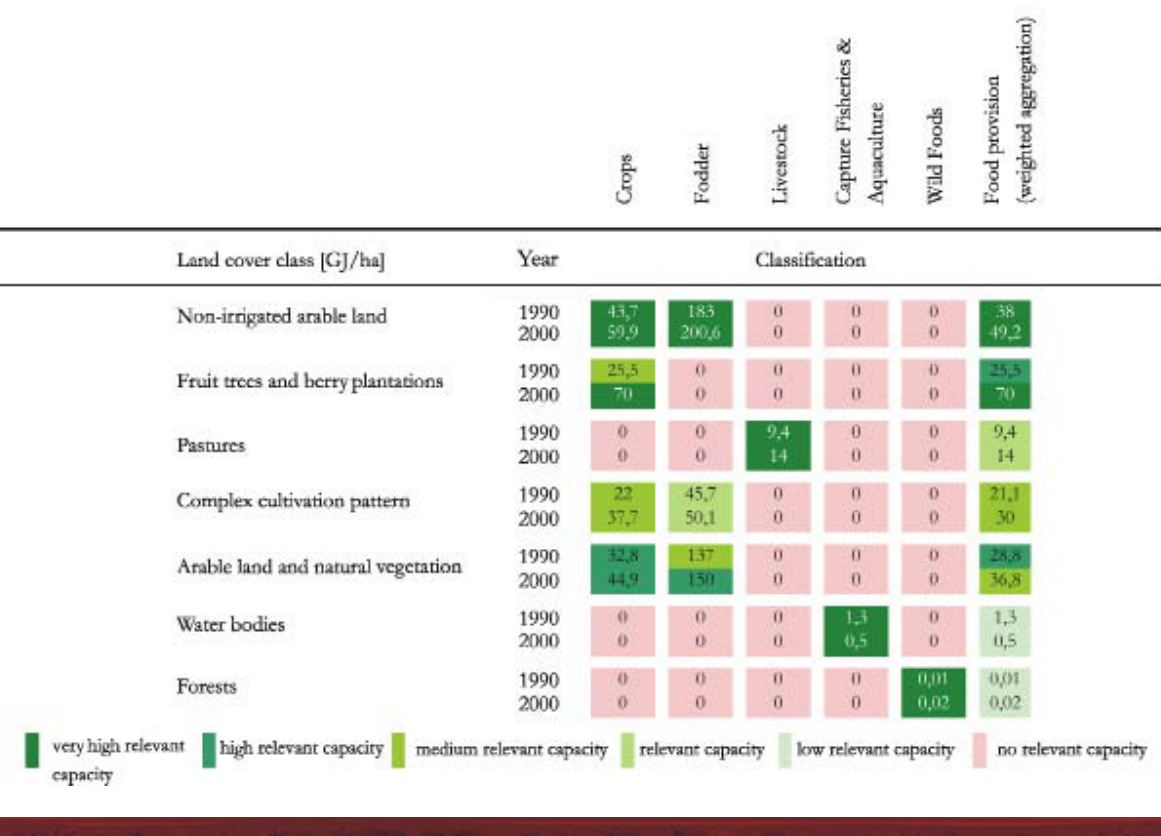
Table 2: Provisioning ecosystem service „food provision“ in the Halle-Leipzig region divided by types of food and land cover classes and as weighted aggregation of all food providing services (Data sources: Saxon State Ministry of the Environment and Agriculture 2001, 2003; KTBL